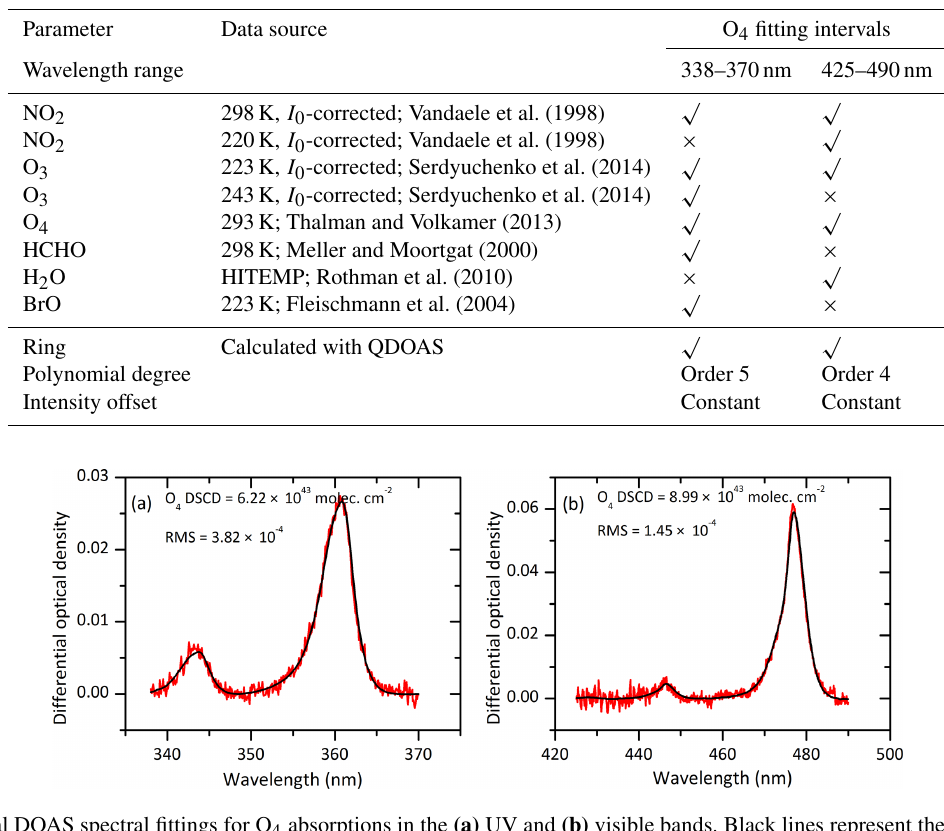
Figure 1. Typical DOAS spectral fittings for O 4 absorptions in the (a) UV and (b) visible bands. Black lines represent the absorption signal and the red lines represent the sum of the absorption signal and the fit